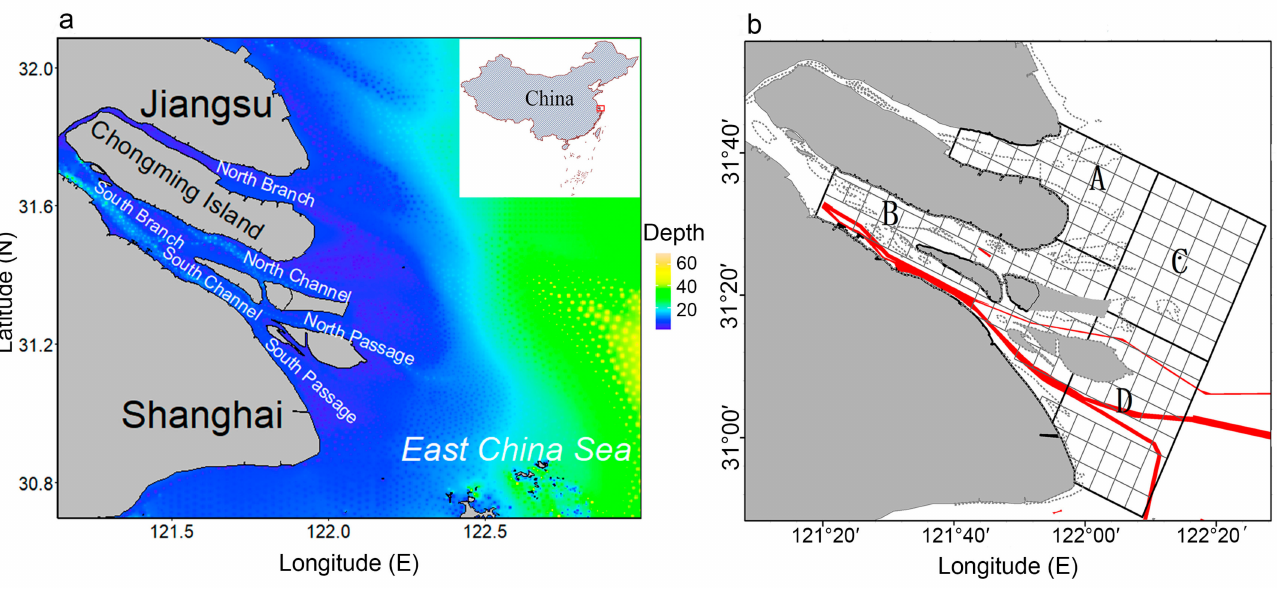
Figure 1. Study area and sampling stations ( a ) Area map and water depth; ( b ) Subareas of the survey, the red area is a deep-water